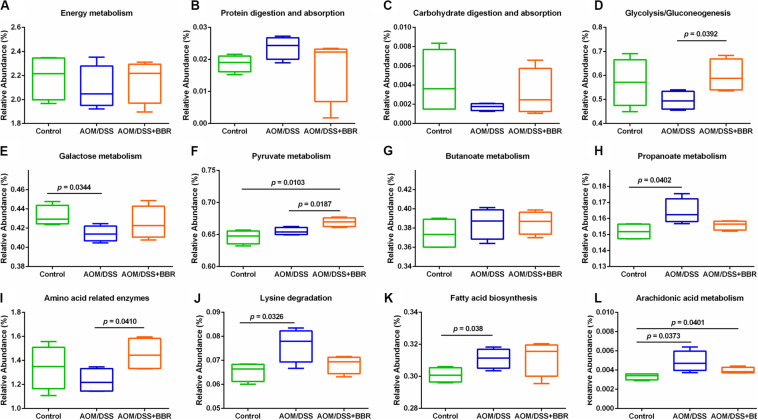
Inferred gut microbiome functions by PICRUSt from 16S rRNA gene sequences among groups. (A–C) Overall conditions of basic metabolism; (D–F) gluco-related metabolism; (G,H) SCFAs-related metabolism; (I,J) amino acid-related metabolism. (K,L) Lipid-related metabolism.